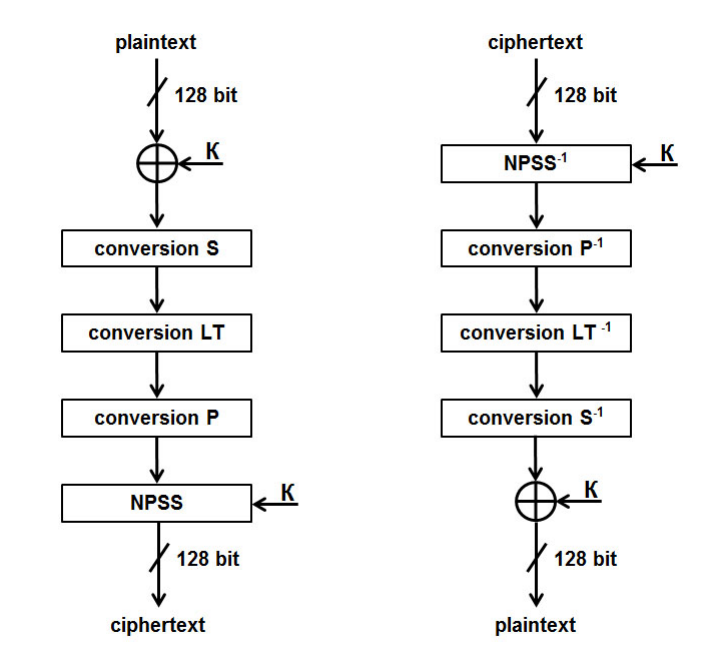
Figure 1: The scheme of the algorithm based on